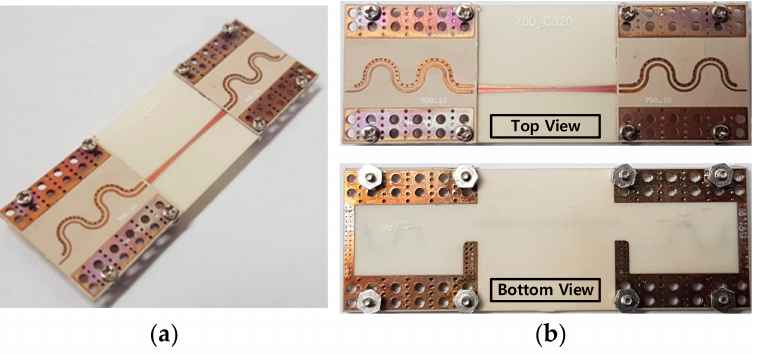
Figure 8. Fabricated back-to-back structure of the proposed compact CPS-to-MSL transition: ( a ) per- spective view, ( b ) top and bottom